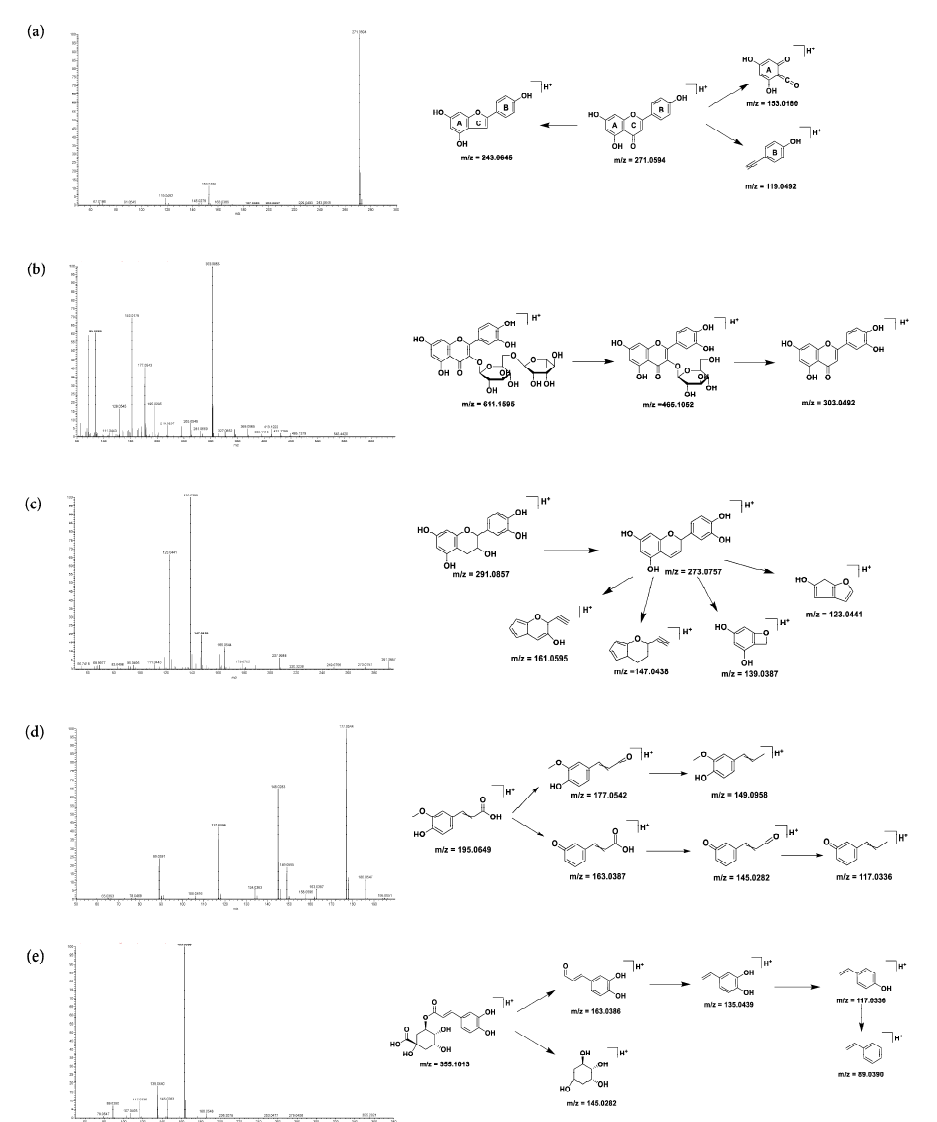
Figure 2. MS 2 spectrometry and fragmentation pattern of compounds in positive ion mode: ( a ) apigenin (flavonoids); ( b ) rutin (flavonoid glycoside); ( c ) catechin (flavane-3-alcohol); ( d ) chlorogenic acid (caffeylquinic acid); ( e ) ferulic acid (cinnamic acid derivative).